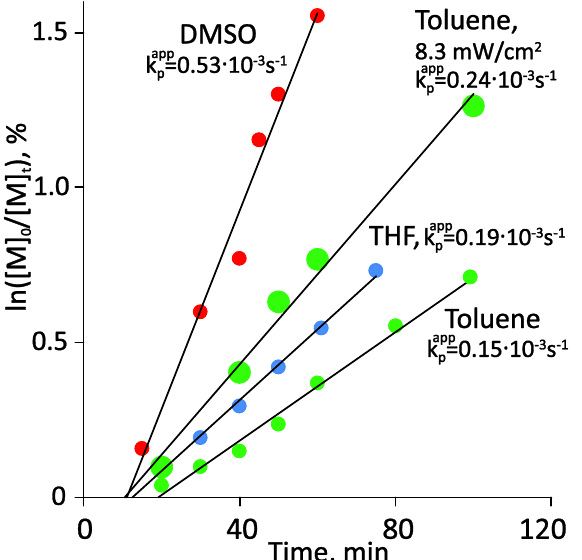
Figure 5. Kinetic first-order plot for the photo-induced RAFT polymerization of MPEGMA without an initiator in different solvents. Polymerization conditions: ω MPEGMA = 50 wt.%, [MPEGMA] 0 /[CDTPA] 0 = 200:1, blue LED, 7 mW/cm 2 (unless otherwise specified), 35 °C.